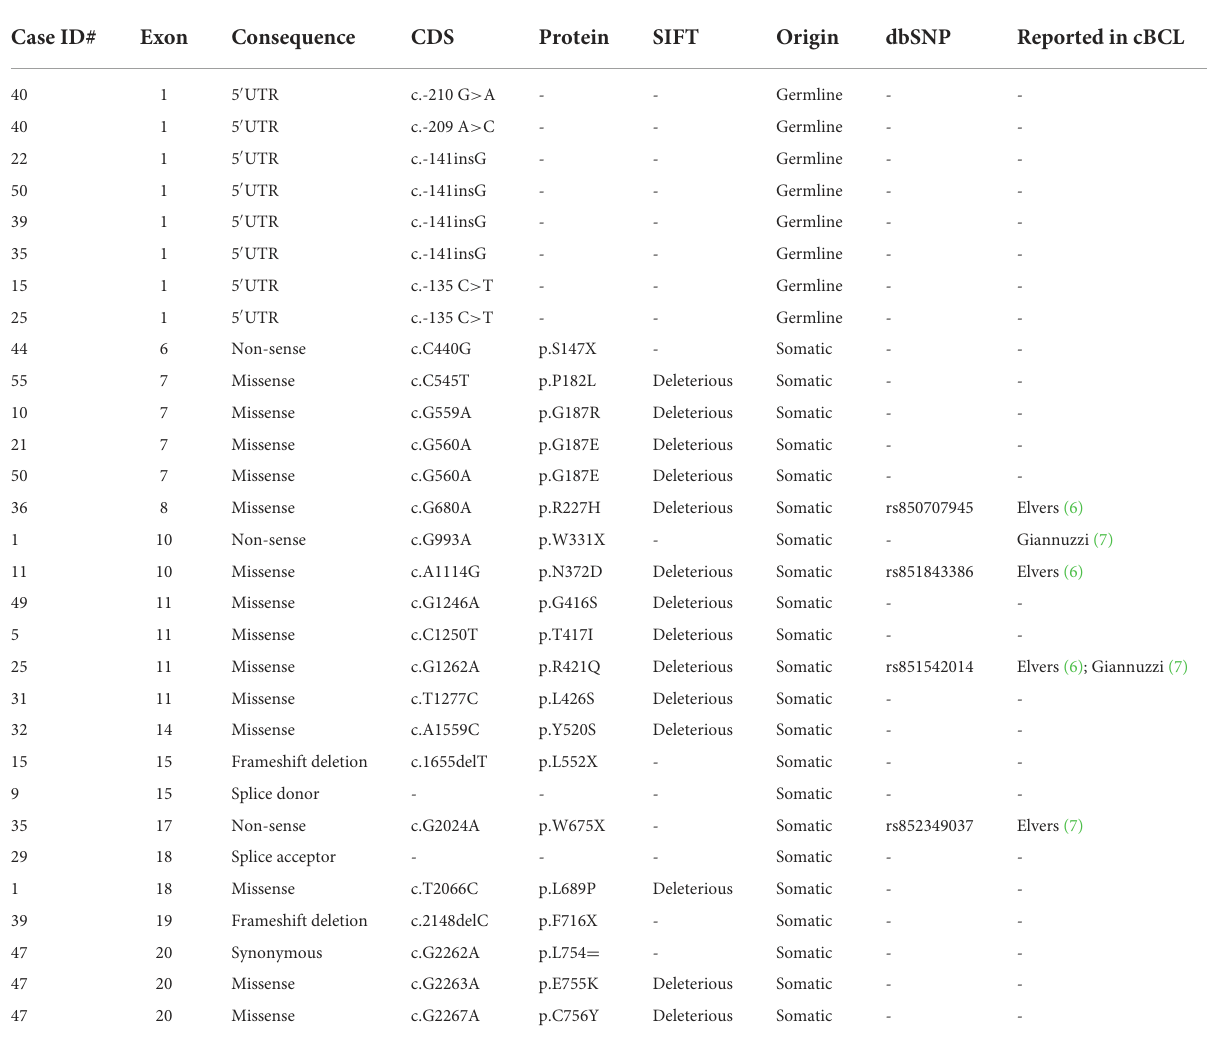
TABLE 1 POT1 variants identified in 56